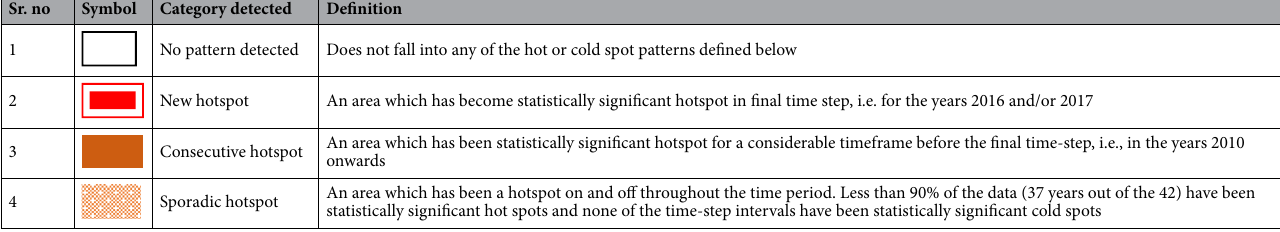
Table 2. Emerging hotspot categories detected and their